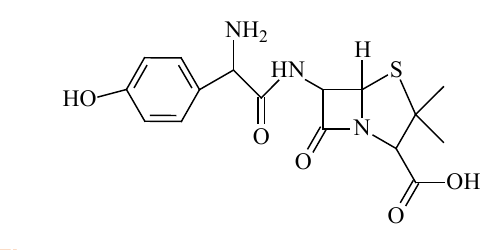
Figure 1. The chemical formula of